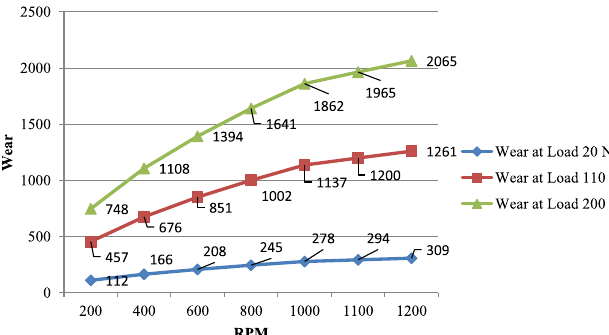
Fig. 9. Wear vs RPM at constant load for Al6061+ SiC.